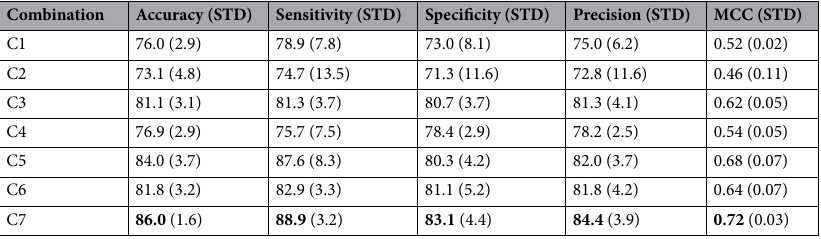
Table 3. Results achieved using fivefold cross validation for ACP-740 dataset for different input feature groups. The STD is also presented in the brackets for each measurement. Bold items indicate the best values found by the methods.